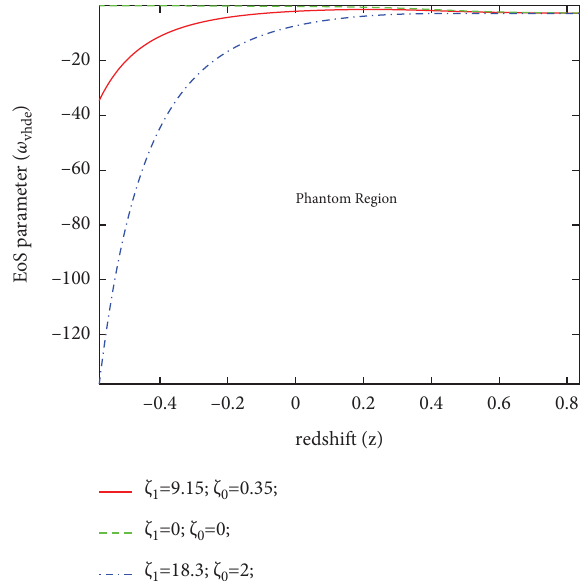
Figure 17: EoS parameter ( ω